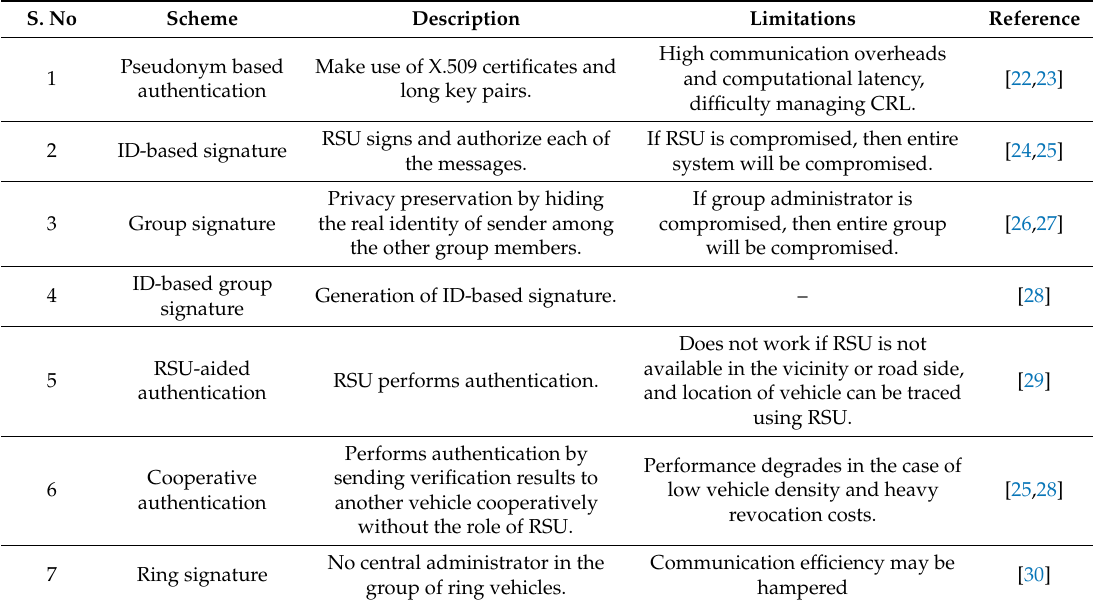
Table 1. Authentication mechanisms in the